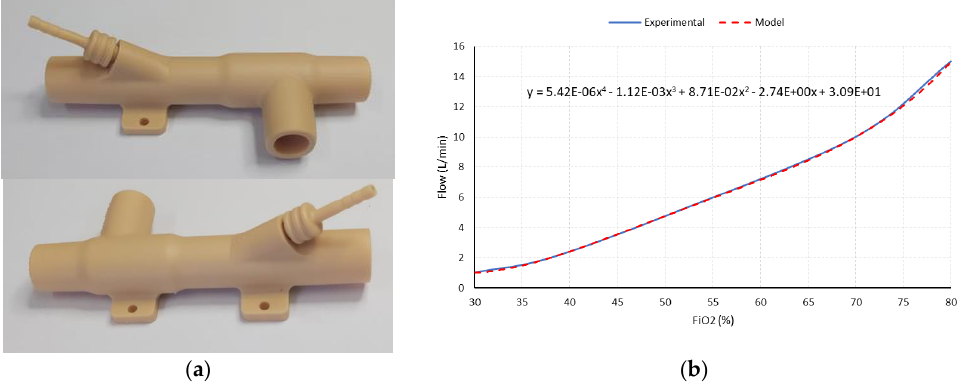
Figure 5. Venturi: ( a ) image; ( b ) FiO 2 as a function of flow.